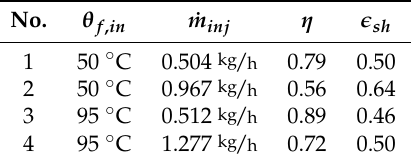
Table 2. Operating parameters related to Rieck et al.